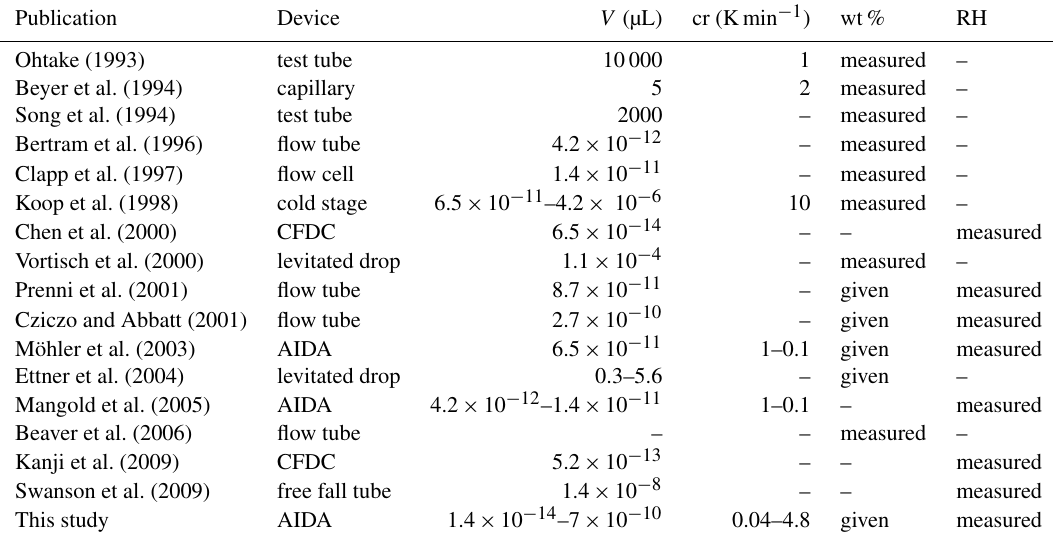
Table 1. Previous measurements of homogeneous freezing of H 2 SO 4 / H 2 O solutions. The columns show the publication citations, the mea- surement device used (where CFDC represents continuous-flow diffusion chamber), the sample volume V , the cooling rate cr (if available), and information about which parameters (weight percentage composition, wt%, or the relative humidity, RH) were measured or derived to characterize the freezing onsets (“measured” means the parameter was directly measured, and “given” means the parameter was calculated, e.g., using E-AIM or